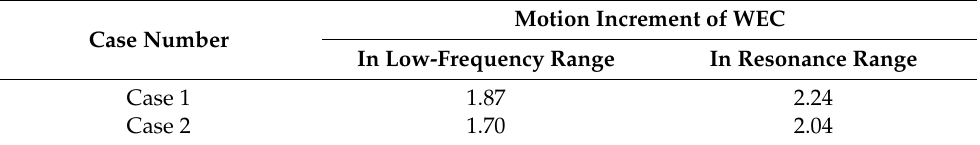
Figure 17. Motion RAOs of the WEC under different conditions. Table 4. Maximum motion increment of the WEC compared to the case of no breakwater. Motion Increment of WEC Case Number In Low-Frequency